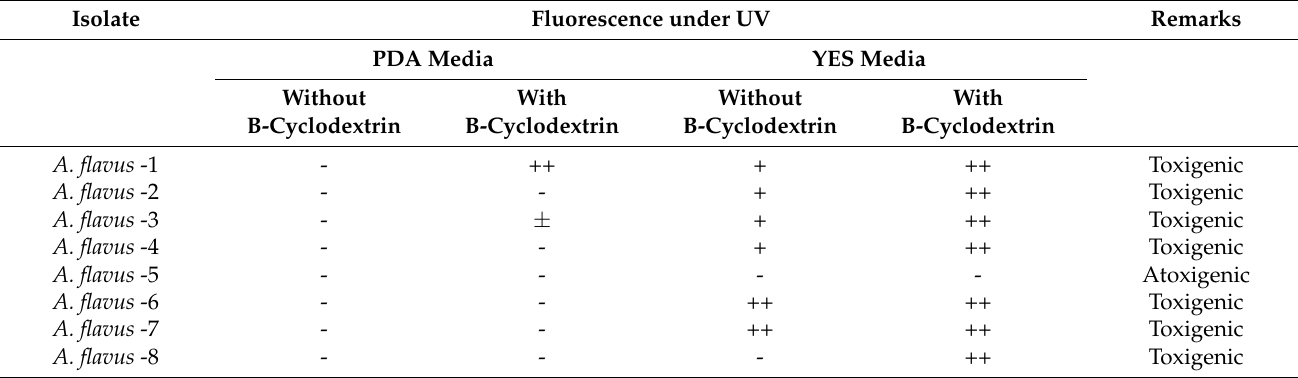
Table 4. Biochemical characterization of non-aflatoxigenic and aflatoxigenic strains from the eight A. flavus isolates. Isolate Fluorescence under UV